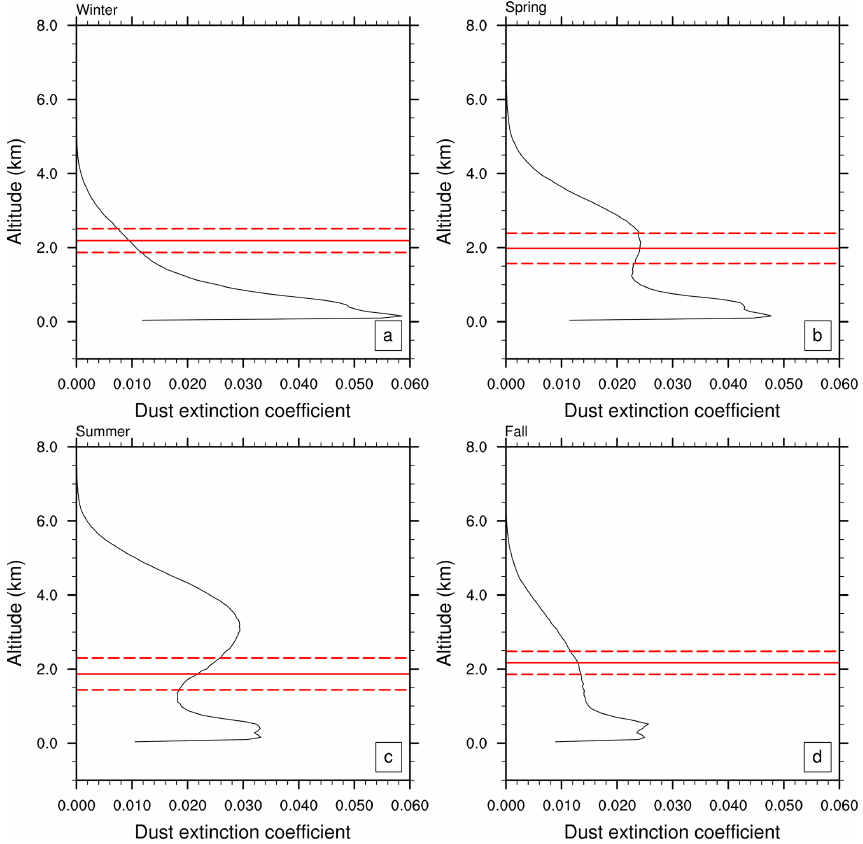
Figure 8. Vertical profile of the dust extinction coefficient from CALIPSO in (a) winter, (b) spring, (c) summer, and (d) fall. Solid and dashed red lines show CERES MSc cloud-top height ± 1 σ for each